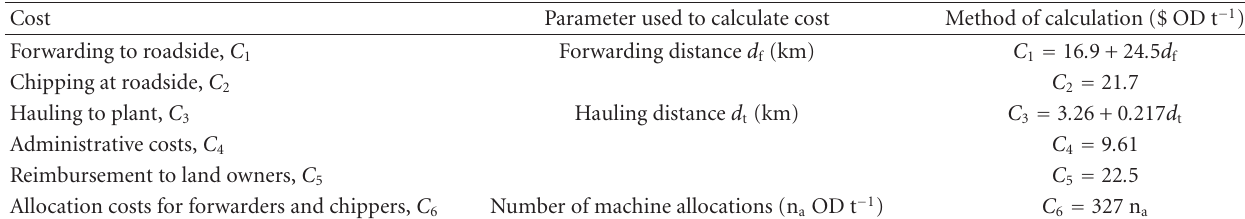
Table 2: Methods for calculating the marginal costs for extraction and delivery of logging residues for the plant